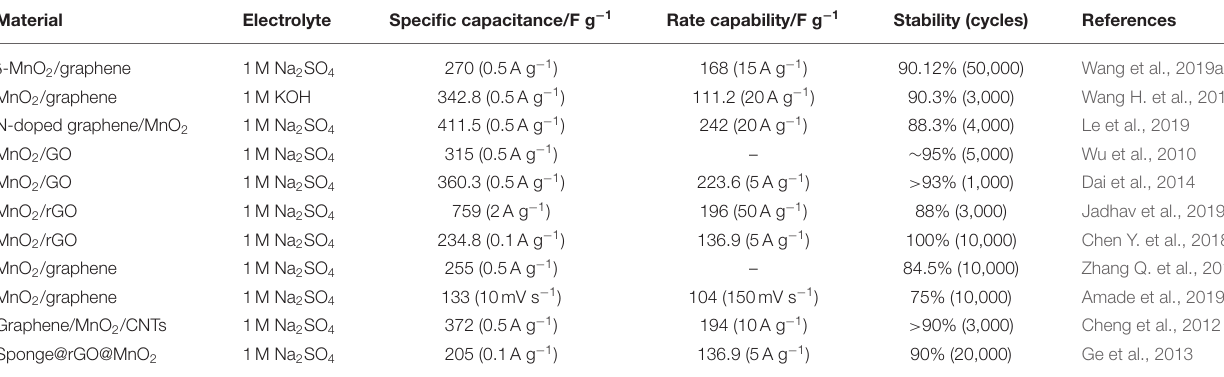
TABLE 2 | Electrochemical performance of various MnO 2 /graphene materials.